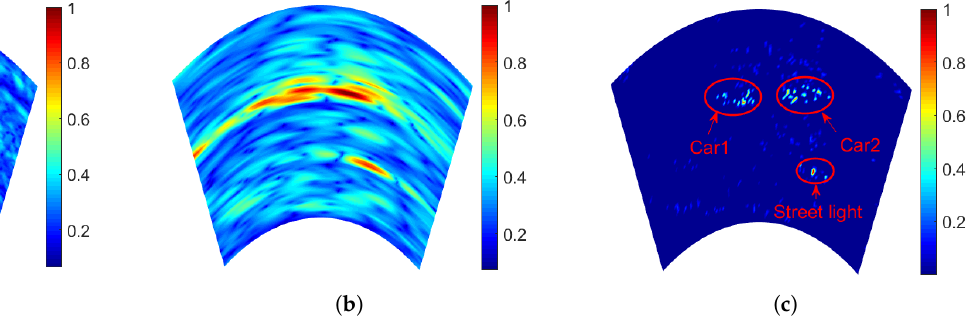
Figure 12. ( a ) BP imaging result of 86 full-aperture antenna echoes. ( b ) BP imaging result of 24 partial- aperture antenna echoes. ( c ) CS imaging result of 86 full-aperture antenna